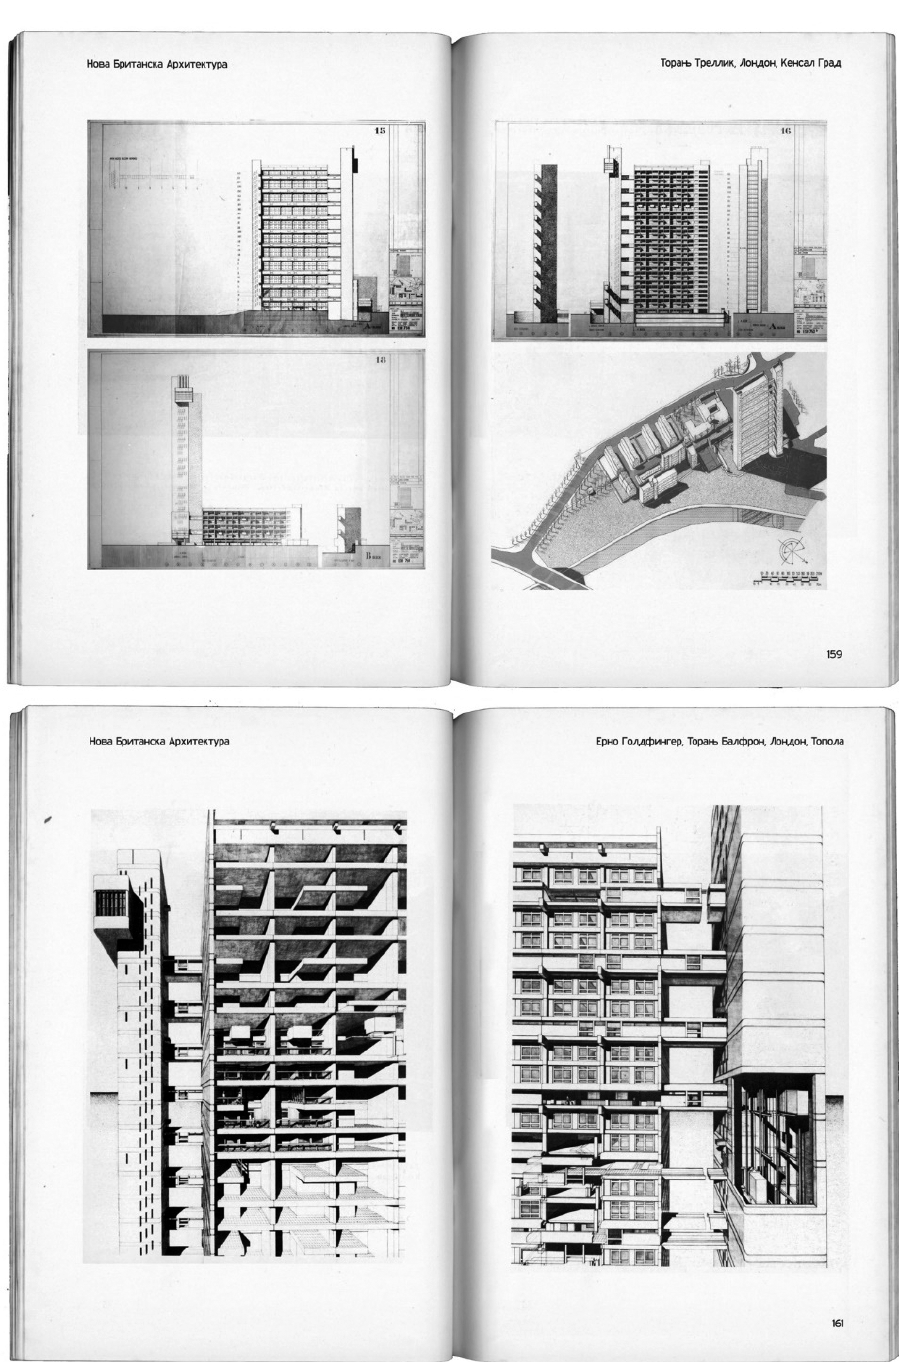
Figure 7. Georgi P. (1979), Nova Britanska Arhitektura , Architektonska Edizia, Novoselo.